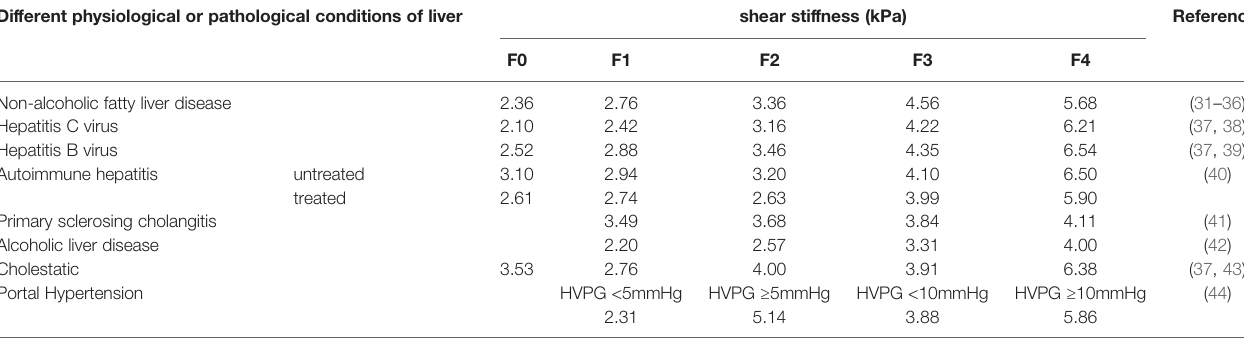
TABLE 1 | Liver shear stiffness (kPa) under different physiological or pathological conditions. Different physiological or pathological conditions of liver shear stiffness